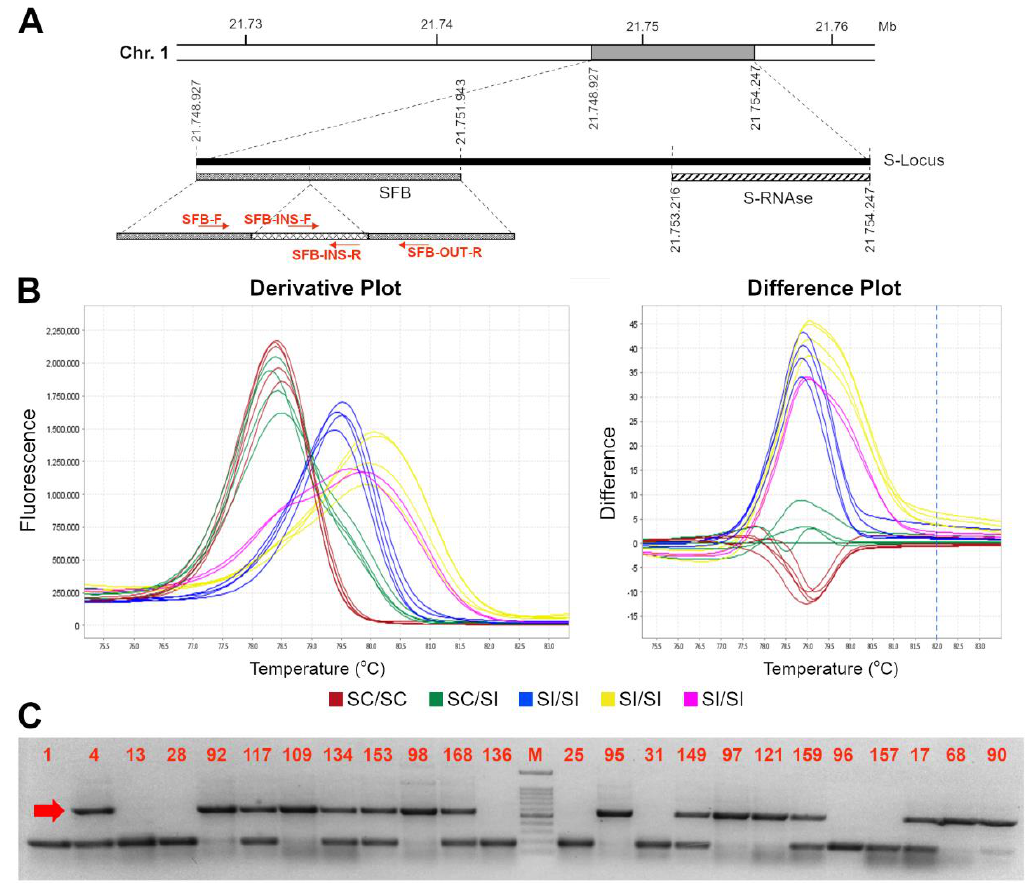
Figure 1. High resolution melting assay for distinction of SFBc genotypes. Schematic representation of the S -locus ( A ). On the left, the SFB gene with the primer used in this work is represented; the light grey line represents the 358 bp inserted element at position 904 to 1.261 from the first nucleotide of the ORF [17]; ( B ) Derivative (left) and difference (right) plots of melting curves from HRMA assays for SFB alleles by using the SFB-F//SFB OUT-R couple of primers: in blue the SC SFB - HOM , in green the SC - HET and in red the SI profiles; (E,F) different possible SFB SI homozygous curves; ( C ) Electrophoresis gel of HRMA product showing SFBc (indicated by the red arrow) and SFB i allele amplicons of ~600 and ~200 bp long, respectively. A 100 bp marker has been used as ladder in the analysis. Accession number is indicated in Table 1.